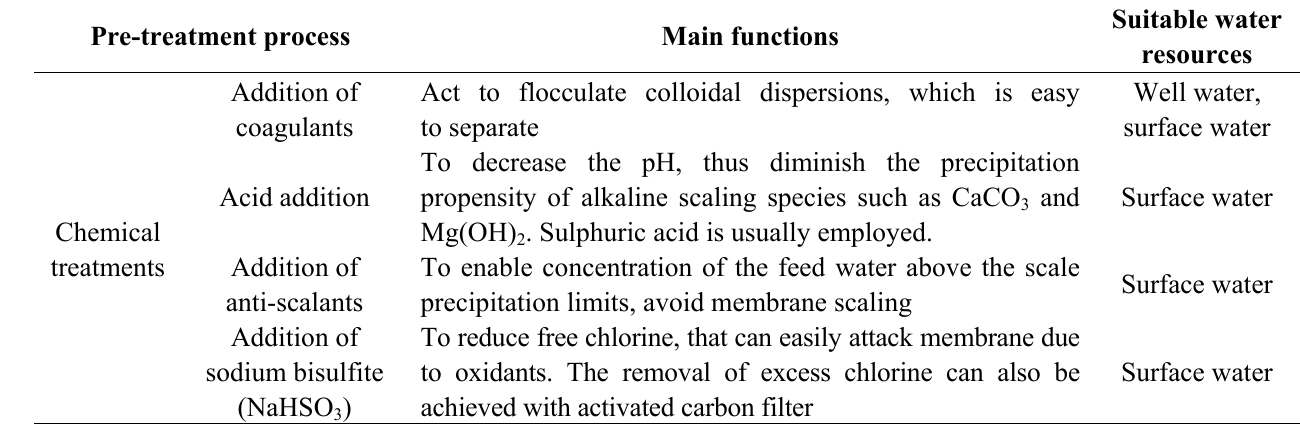
Table 2. Pre-treatment Processes, summarized from references